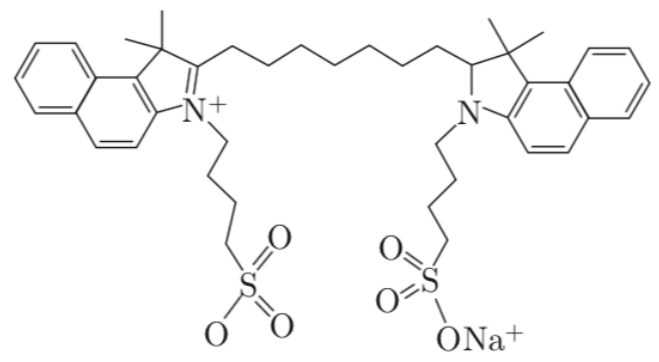
Figure 3. Chemical structure of indocyanine green [52].